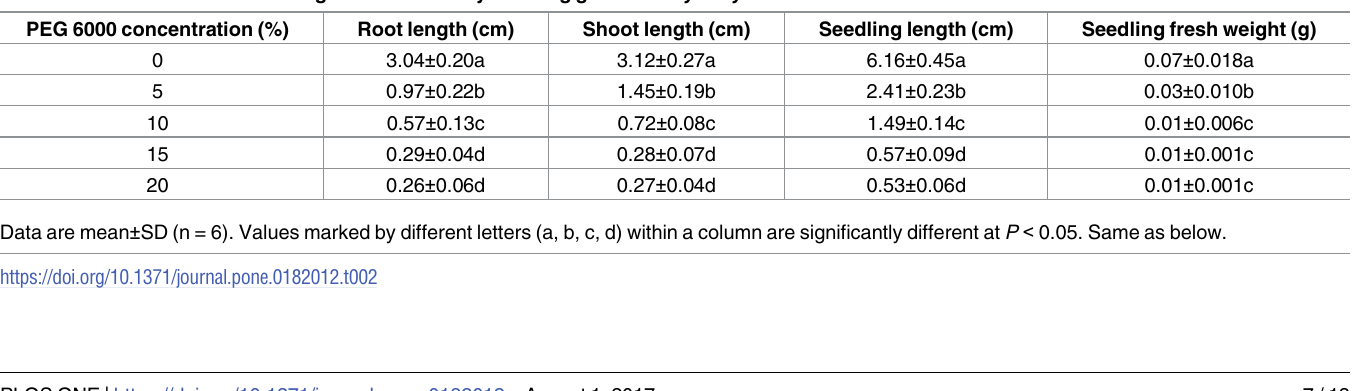
Table 2. Effects of simulated drought stress on early seedling growth of Nyssayunnanensis . PEG 6000 concentration (%)